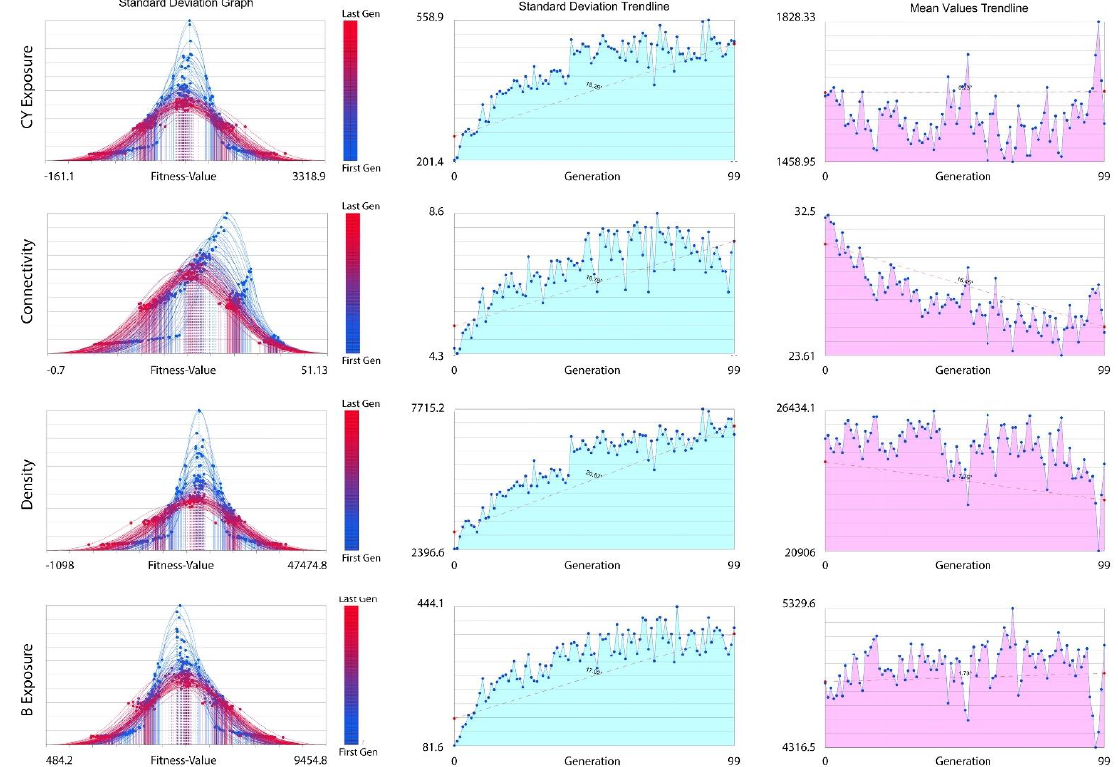
Figure 8. Standard deviation graph, standard deviation trend line, and mean values trend line for all of the fitness criteria: CV Exposure (number of mesh faces), Connectivity (numeric value based on Figure 5, Density (hab/km 2 )), and B Exposure (number of mesh faces). Comparison of the objective fitness values in all generations, from blue (first generation) to red (last generation).